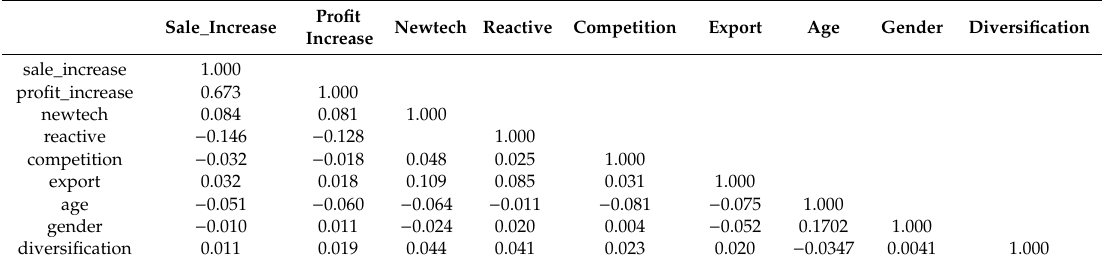
Table 3. Correlation matrix of variables in the